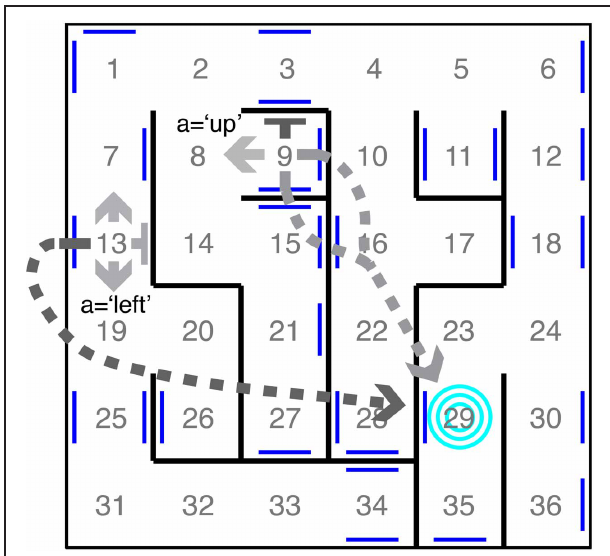
FIGURE 1 | Example maze. The 36 states correspond to rooms in a maze. The four actions correspond to noisy translations in the cardinal directions. Two transition distributions are depicted, each by a set of four arrows emanating from their originating states. Flat-headed arrows represent translations into walls, resulting in staying in the same room. Dashed arrows represent translation into a portal (blue lines) leading to the absorbing state (blue target). The shading of an arrow indicates the probability of the transition (darker color represents higher